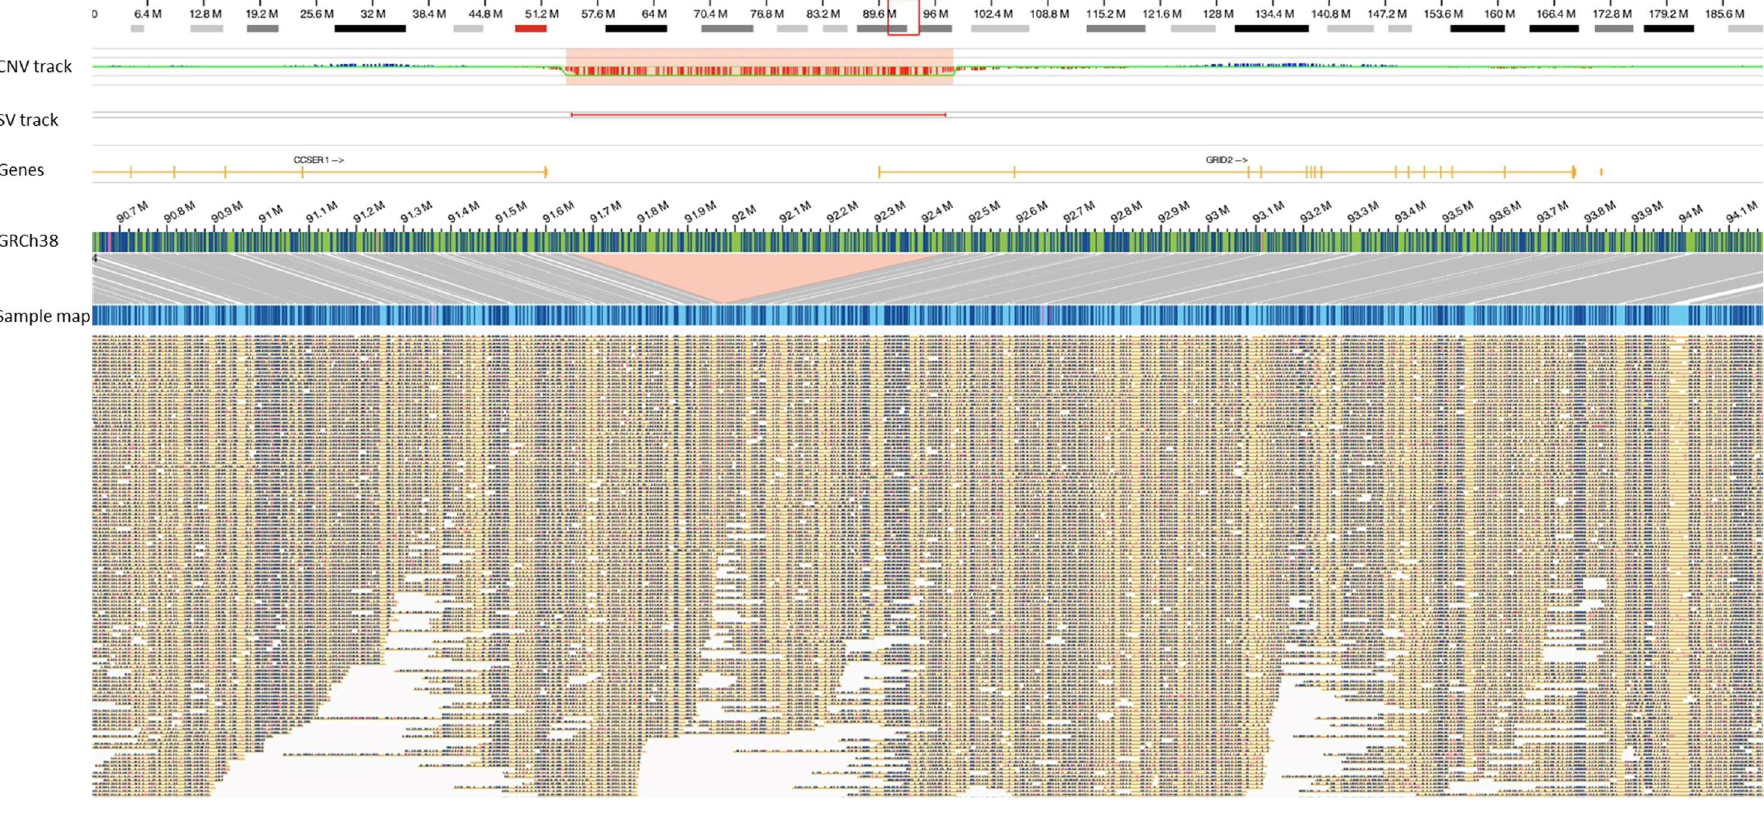
Figure 3. A ~784.3 kb deletion of chr 4 (chr4:91654881–92444482) disrupting the GRID2 gene in one patient (case 23). The deletion is highlighted with the region in red.